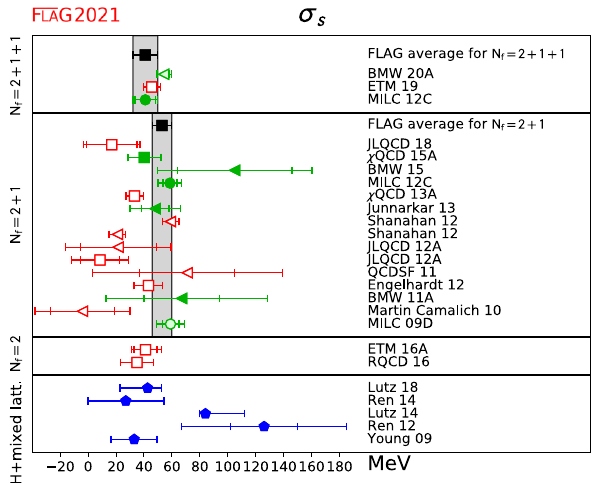
Fig. 48 Lattice results and FLAG averages for σ s for the N f = 2, 2 + 1, and 2 + 1 + 1 flavour calculations. Determinations via the direct approach are indicated by squares, the Feynman–Hellmann method by triangles and the hybrid approach by circles. Results from calculations which analyze more than one lattice data set within the Feynman–Hellmann approach [1022,1023,1025,1026,1029] are shown for comparison